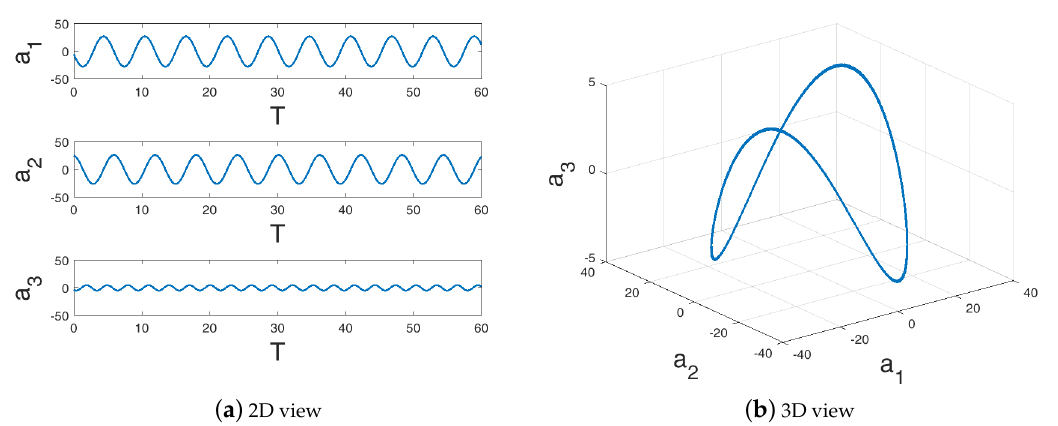
Figure 4. The temporal evolution of the first three normalized proper orthogonal decomposition (POD) coefficients for the limit cycle cylinder flow at Re =